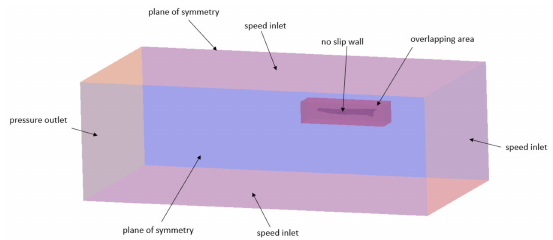
Figure 2. Setting of boundary